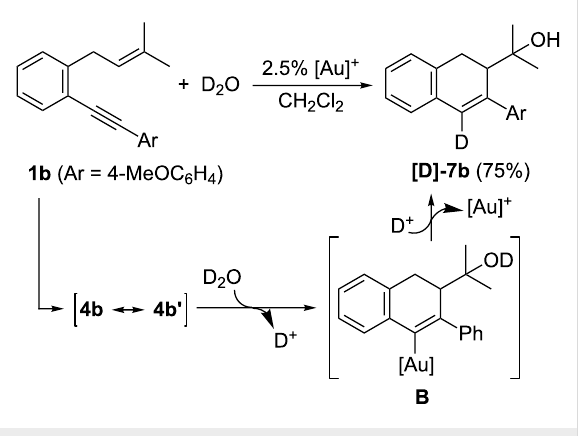
Scheme 8: Labelling experiment and proposed